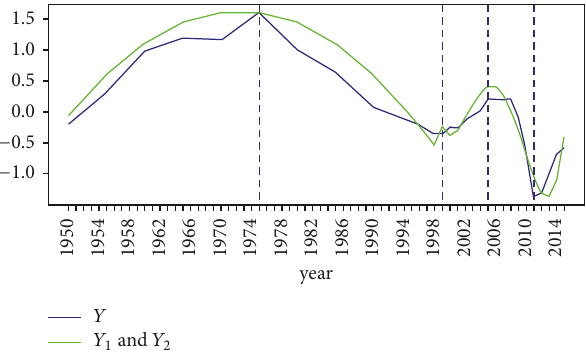
Figure 5: Trend analysis of Pakistan’s railway industry from 1950 to